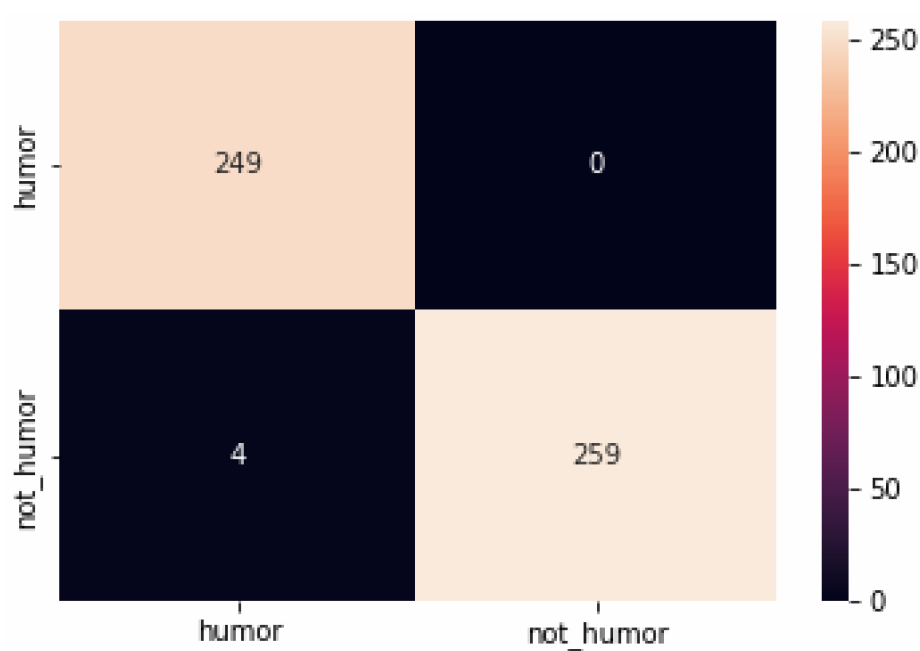
Figure 2. Confusion matrix of each model on Pun of the Day dataset.